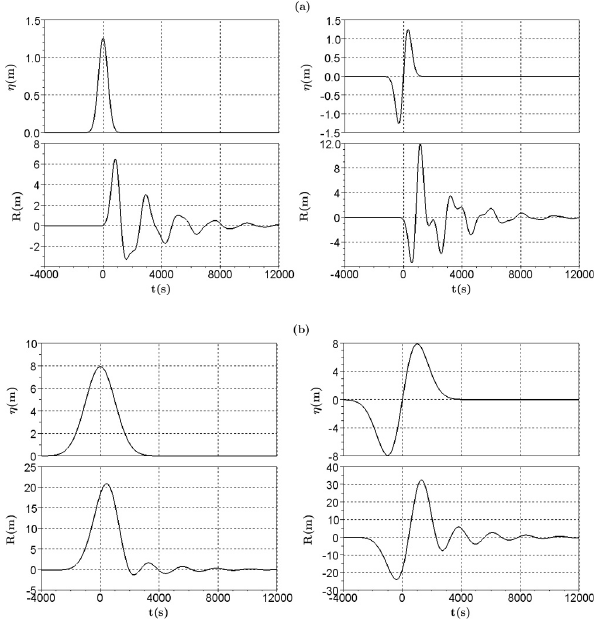
Fig. 3. Incident wave and water oscillations on the shore for h 0 = 2500m, x 2 = 23km, h 1 = 150m, x 0 = 15km, tan α = 0 . 005, tan β = 0 . 1, and different earthquake magnitudes: (a) M = 7 . 5 ( L = 35km) and (b) M = 8 . 5 ( L = 110km).